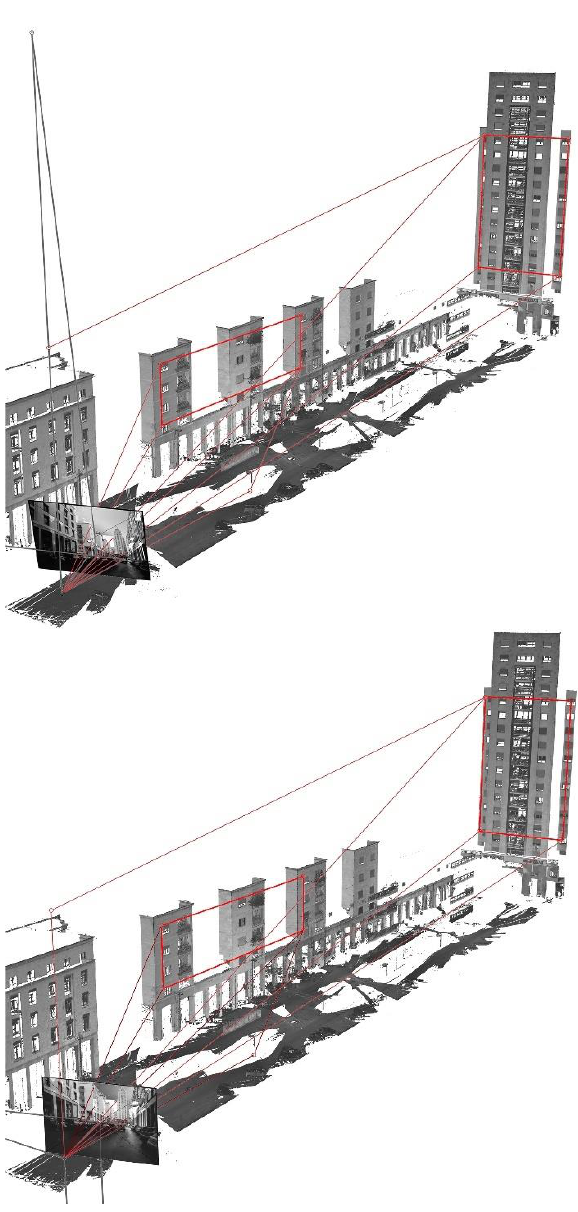
Figure 13: External orientation of View Camera’s images in neutral position (above) and with the rear standard tilt correction